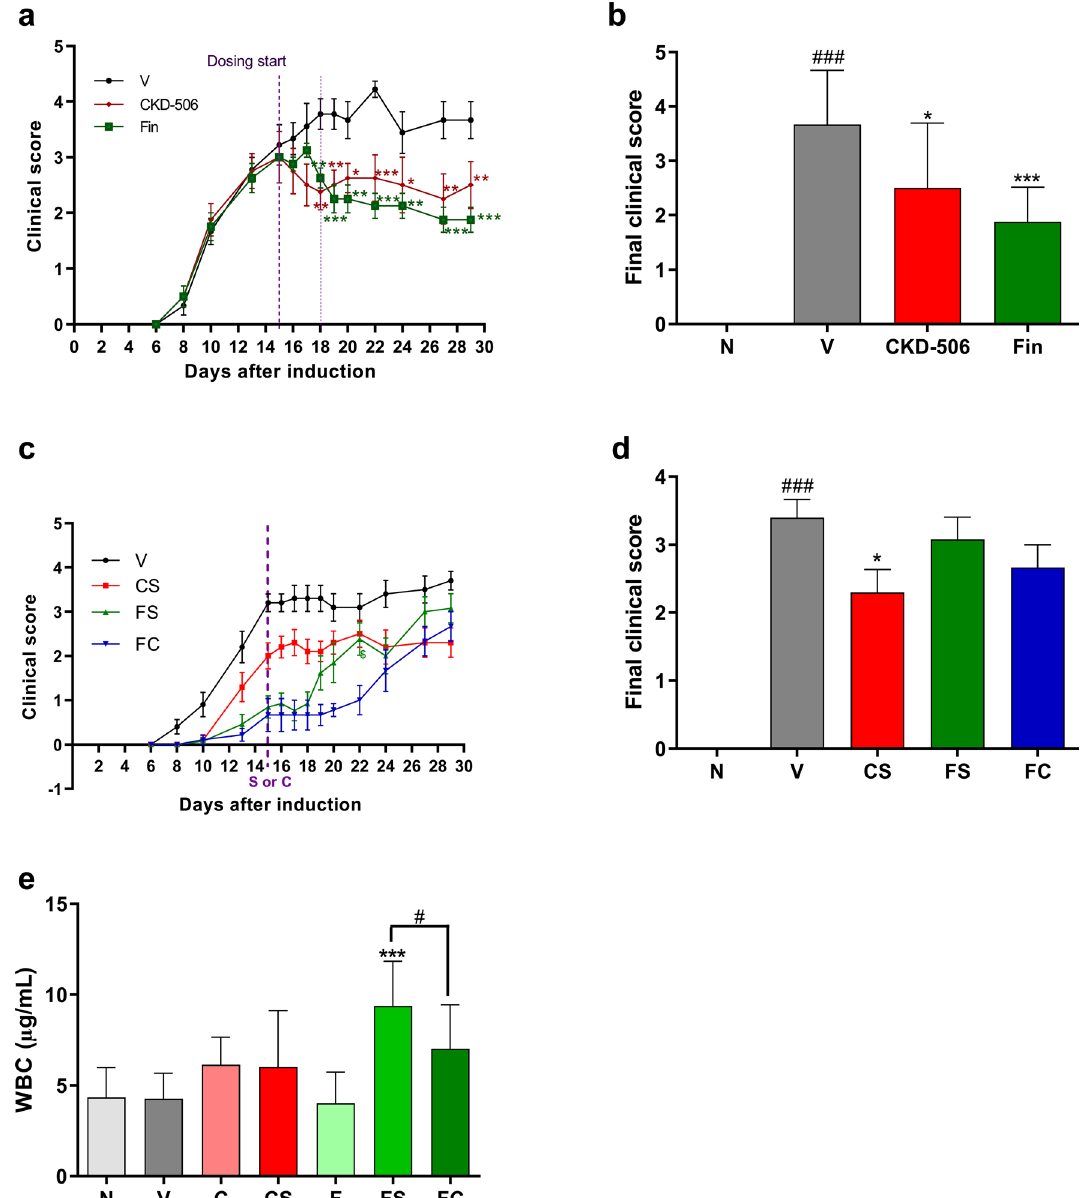
Figure 6. CKD-506 decreased the clinical scores in mice with experimental autoimmune encephalitis (EAE) under the therapeutic regimen. C57BL/6 (n = 9 per group for the non-immunized groups and vehicle group; n = 8 per group for the other groups) mice were orally administered CKD-506 (30 mg/kg bodyweight) and fingolimod (0.3 mg/kg bodyweight) daily from day 15 post-myelin oligodendrocyte glycoprotein 35–55 immunization ( a , b ). The clinical score ( a ) and final clinical score ( b ) were determined. The CKD-506-treated group exhibited alleviated clinical scores even after CKD-506 discontinuation and delayed disease exacerbation after fingolimod discontinuation ( c , d ). Mice (n = 12 per group for FS; n = 10 per group for the other groups) were treated with CKD-506 (30 mg/kg bodyweight) and fingolimod (0.3 mg/kg bodyweight) from days 6 to 14 post-induction. Treatment was discontinued or changed from fingolimod to CKD-506 on day 15 post- induction. The clinical score ( c ), final clinical score ( d ), and the number of white blood cells in the blood ( e ) were evaluated. Data are presented as mean ± SD. Two-way ANOVA, followed by Bonferroni post-hoc test for ( a , c ); one-way ANOVA, followed by Dunnett’s post-hoc test for ( b , d , e ). # p < 0.05, ### p < 0.001, non- immunized groups versus vehicle group; * p < 0.05, ** p < 0.01, and *** p < 0.001, drug-treated group versus vehicle group; $ p < 0.05, FS versus FC. N, non-immunized groups; V, vehicle group; Fin, fingolimod-treated group; CS, CKD-506-treated group in which dosing of CKD-506 was discontinued from day 15 post-induction; FS, fingolimod-treated group in which treatment was discontinued from day 15 post-induction; FC, the group in which fingolimod was replaced with CKD-506 on day 15 post-induction; S, dosing stop; C, treatment change from fingolimod to